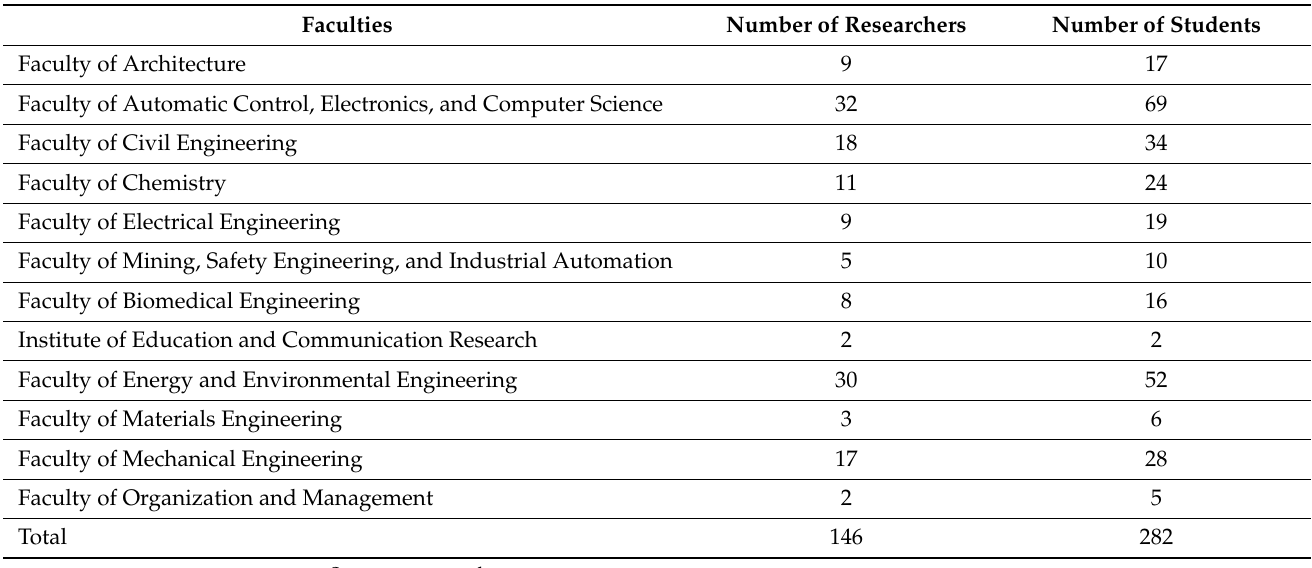
Table 3. Scientists and students from faculties involved in PBL.